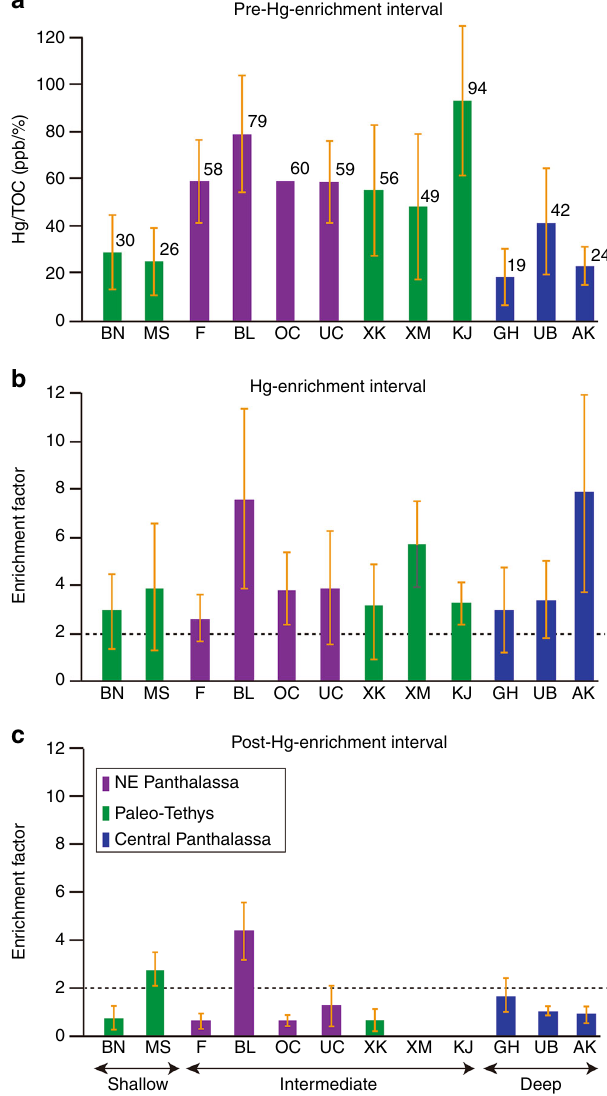
Fig. 2 Mercury enrichment levels relative to latest Permian mass